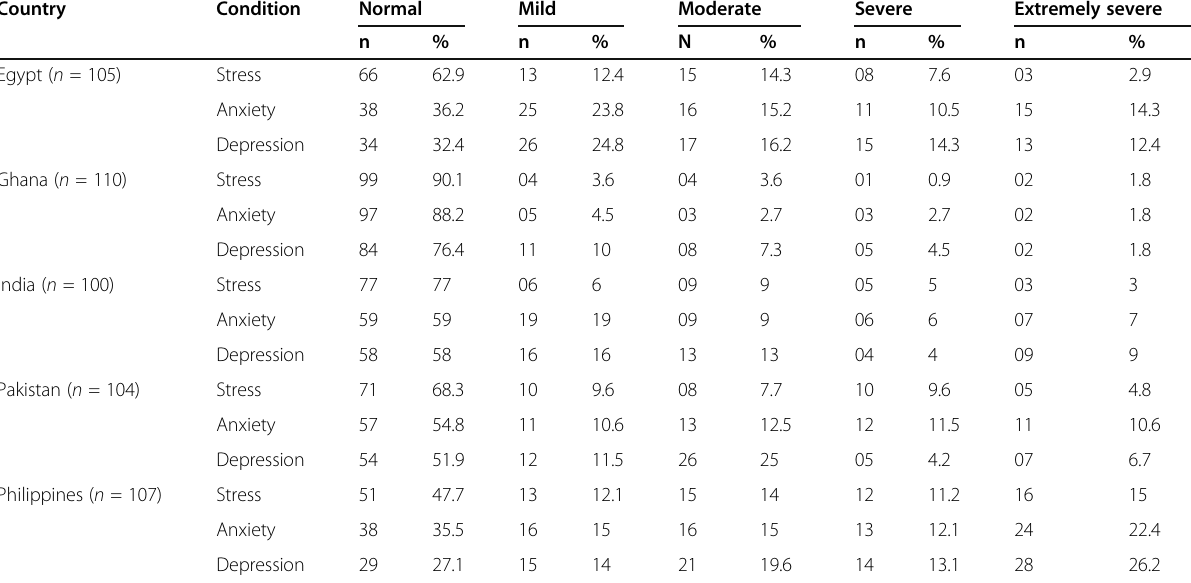
Table 1 Prevalence of stress, anxiety, and depression levels among Egypt, Ghana, India, Pakistan, and Philippines Country Condition Normal Mild